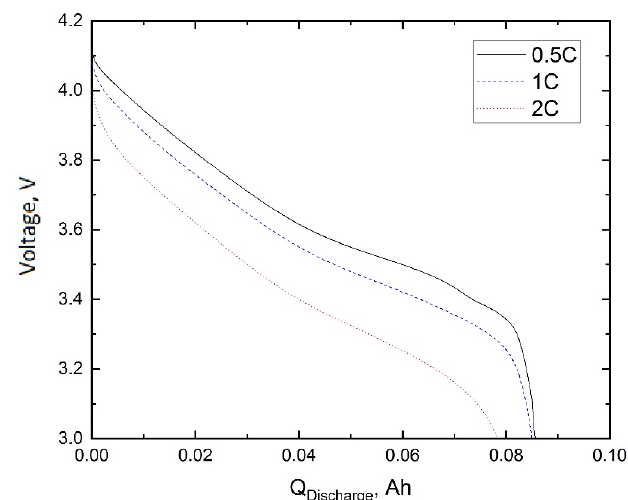
Figure 1. Voltage as a function of the discharge capacity Q Discharge for three different discharging rates.